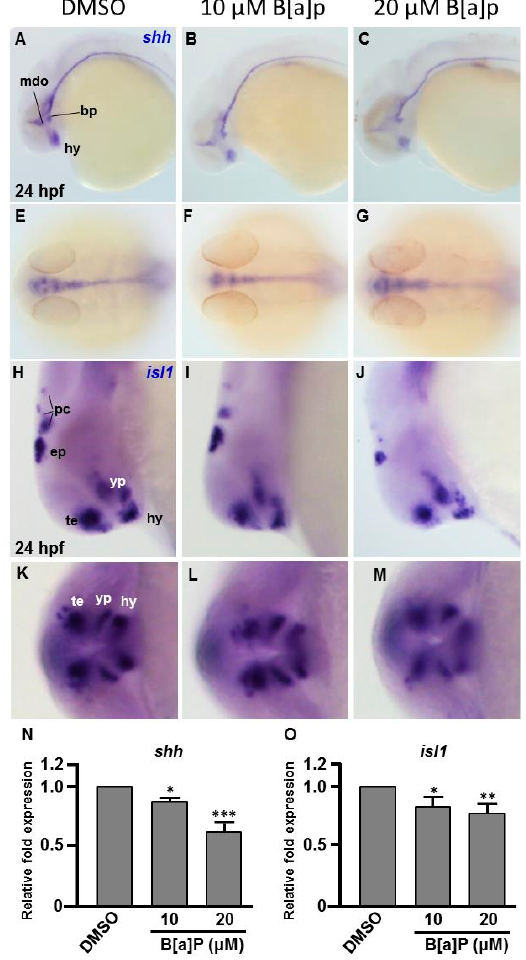
Figure 3. Expression patterns of shh and isl1 are dose-dependently affected by B[a]P exposure. Wild- type (AB) zebrafish embryos were treated with 0 μ M. (control, 01% DMSO), 10- μ M B[a]P and 20- μ M B[a]P. The embryos were fixed at 24 hpf. Expression of shh ( A – G ) and isl1 ( H – M ) was analyzed by in situ hybridization staining. Images show the lateral view in ( A – C , H – J ). Images in ( E – G ) show the dorsal view. Images in ( K – M ) show the frontal view; ( B , C ) Expression of shh was specifically expressed in the mid-diencephalic organizer (mdo), hypothalamus (hy) and basal plate (bp) of B[a] P- treated embryos; ( E – G ) The expression pattern of shh in the brain and floor plate (fp) in 20- μ M B[a] P- treated embryos; ( H – M ) The development of encephalic regions was examined by in situ hybridization staining by probing for the islet1 gene ( isl1 ) which is specifically expressed in telencephalon (te), ventral thalamus (vp), hypothalamus (hy), epiphysis (ep) and posterior commissure (pc) in embryos at 24 hpf. (N, O ) Expression alteration of shh and isl1 in B[a]P was quantified by real-time quantitative RT–PCR (* p < 0.05, ** p < 0.01, *** p < 0.001 compared with the control).